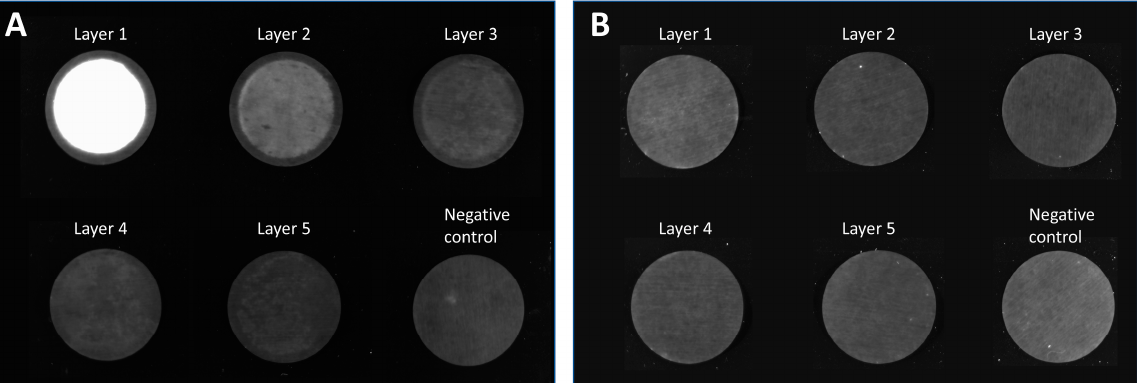
Figure 2. Membrane layers of an MA15 device after loading lentiviral vectors labeled with an anti- VSV-G Alexa Fluor ® 546 antibody. Membrane layers were separated after the ( A ) loading and wash step of steric exclusion chromatography or ( B ) after the elution step. A membrane that was not incorporated into the device served as a negative control.